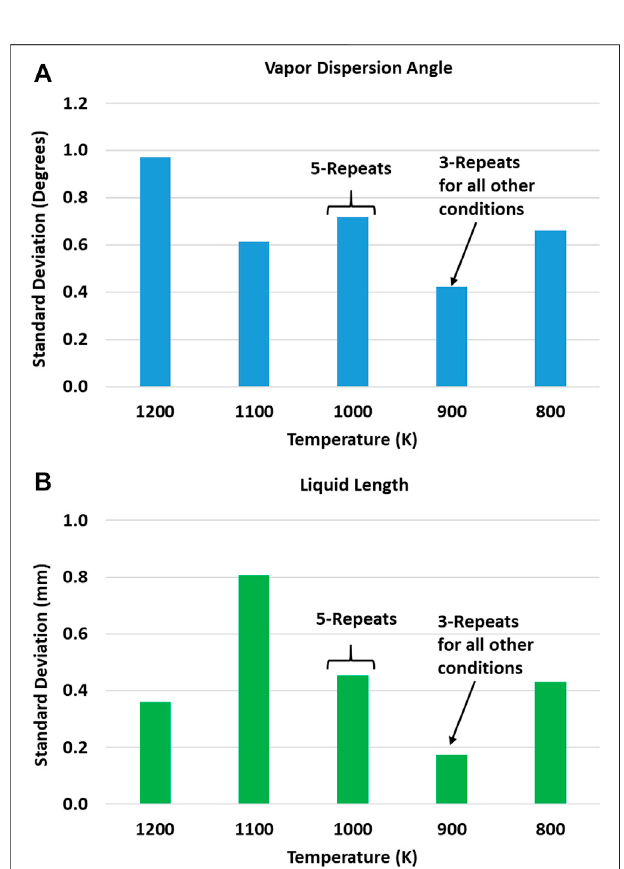
FIGURE 10 | Standard deviation of RON92 measurements for (A) vapor dispersion angle and (B) liquid length at ρ a = 22.3 kg/m 3 using different numbers of test